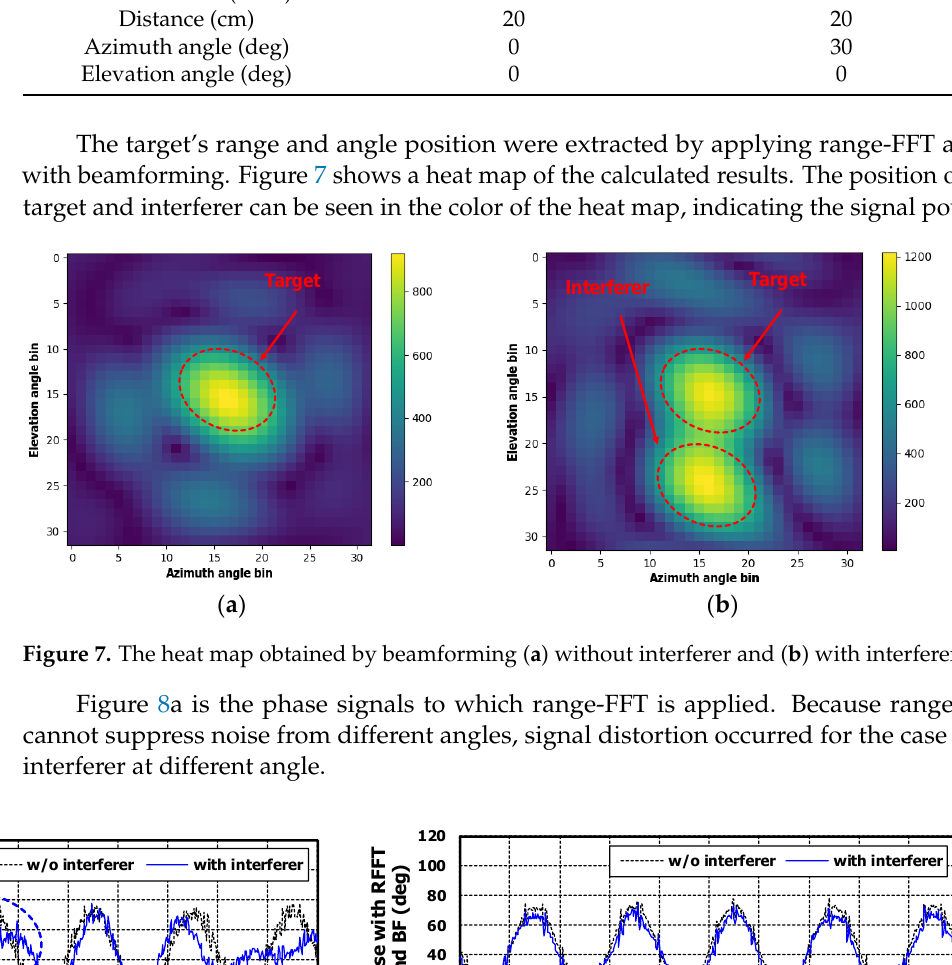
Table 2. Simulation information with interferer in a different angle.